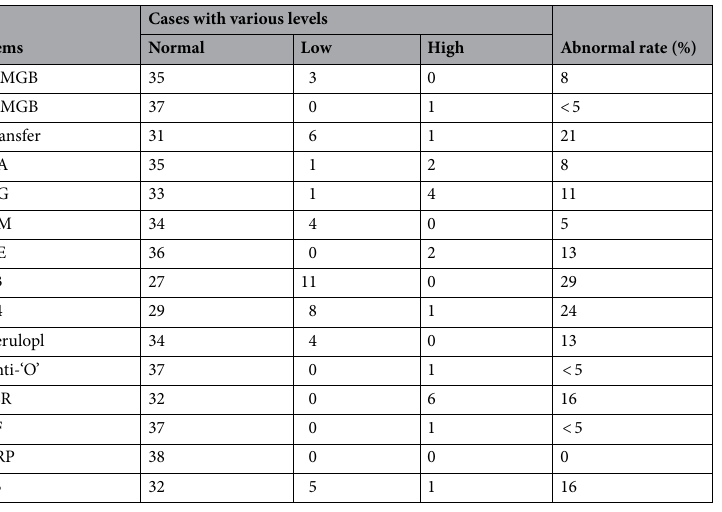
Table 1. Results of standard laboratory tests in patients with Meniere’s disease. Low and high values are located outside the 95% confidence limit of normal values. α1MGB, alpha1-microglobulin; Anti-‘O’, Anti-Streptolysin O antibody; β2MGB, beta2-microglobulin; C3 and C4, complement 3 and 4; Cerulopl, ceruloplasmin; CRP, C-reactive protein; ESR, erythrocyte sedimentation rate; IgA, IgG, IgM, and IgE, immunoglobulins A, G. M, and E; RF, rheumatoid factor; Transfer,